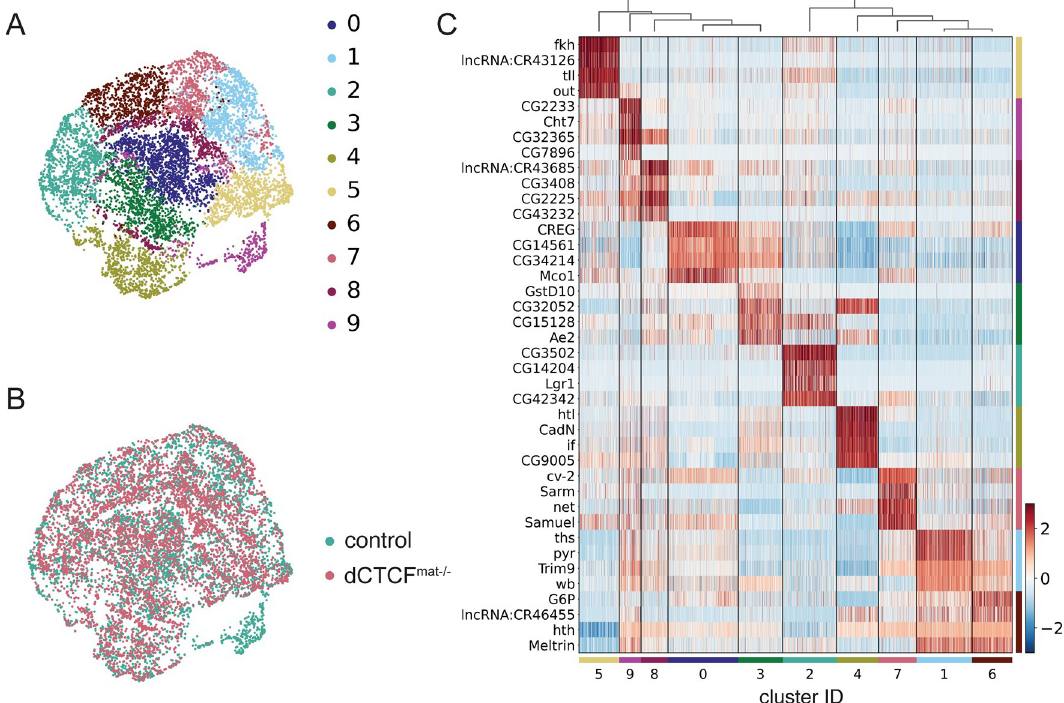
Fig 1. Single-nucleus RNA-sequencing analysis of pre-cellularization Drosophila melanogaster embryos (A) Two-dimensional UMAP embedding of nuclei shows 10 transcriptionally distinct clusters, as determined using the Leiden algorithm. Associated colors are maintained throughout the manuscript. (B) Two-dimensional UMAP embedding of nuclei labeled by condition shows the overlap of control and dCTCF mat-/- nuclei in a reduced dimensional space following correction for non-biological variability. Associated colors are maintained throughout the manuscript. (C) Heatmap of scaled gene expression for top four marker genes of each cluster, clusters are hierarchically ordered.